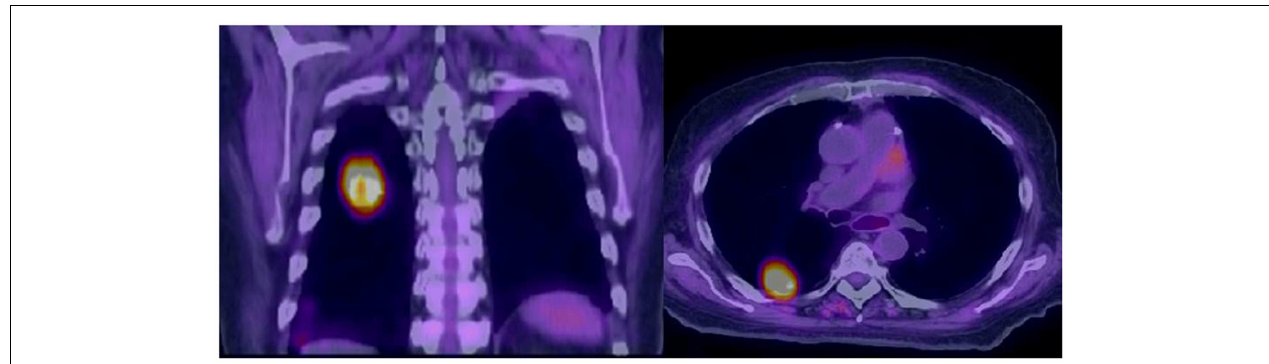
FIGURE 1 | Misalignment of a recurrent squamous cell carcinoma between free-breathing PET and CT is demonstrated .The superior portion of the PET avid tumor does not correspond to any anatomically visible tumor on CT.